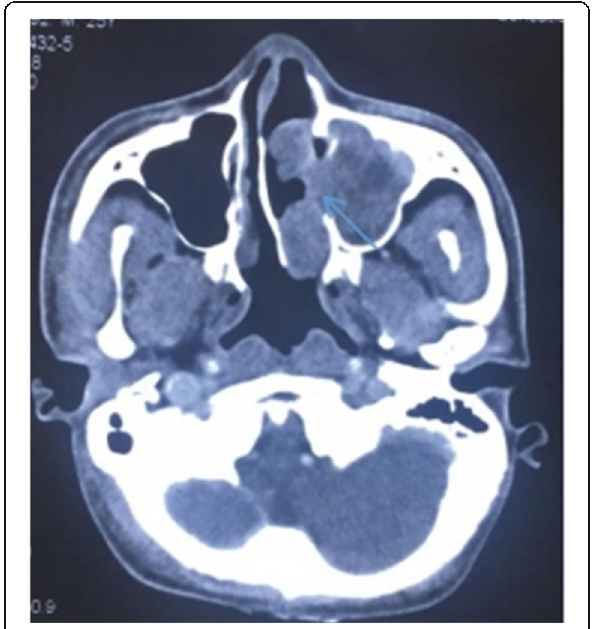
Fig. 2 CECT scan showed a heterogeneous mass arising from the left maxillary sinus extending to the left nasal cavity through the widened secondary ostium